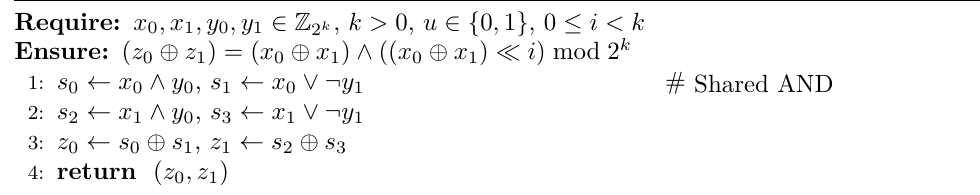
Algorithm 9 Optimized 2-Share TI of a k -radix AND gate ( SecAndOpt )